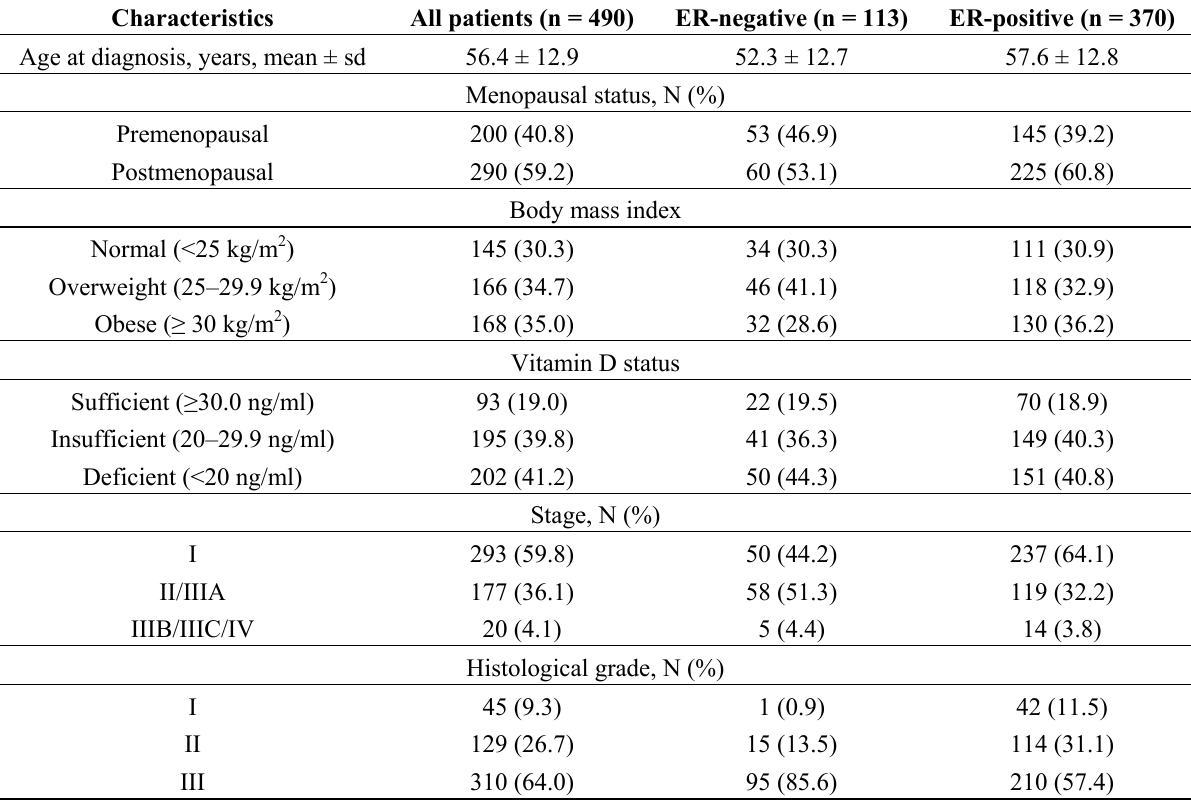
Table 1. Descriptive characteristics of breast cancer patients from the Data Bank and Biorepository (DBBR) overall and by estrogen receptor